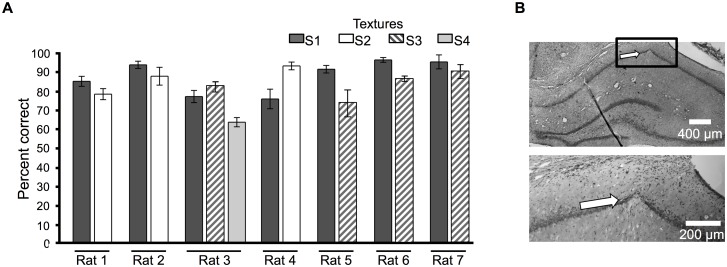
Behavioral performance and hippocampal histology.
(A) Mean behavioral performance of each of seven tested rats during recording sessions. Values are mean percent correct trials ± standard error of the mean (SEM) across sessions, separated according to the stimulus presented. The number of sessions per rat included in the analysis was as follows: Rat 1: 5 sessions, 551 trials; Rat 2: 11 sessions, 1,020 trials; Rat 3: 2 sessions, 312 trials; Rat 4: 5 sessions, 541 trials; Rat 5: 5 sessions, 433 trials; Rat 6: 9 sessions, 1,127 trials; Rat 7: 4 sessions, 181 trials. (B) Histological section. White arrow indicates the electrode track within CA1 subfield of hippocampus. The boxed area of the upper photograph is shown at higher magnification below. All data are available at http://figshare.com/s/99b31b8a567f11e5b81d06ec4bbcf141.